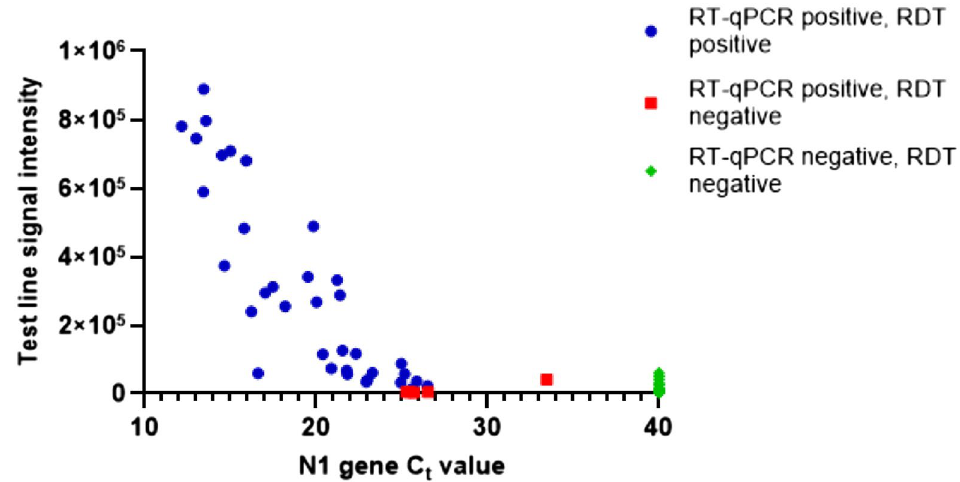
Figure 7. Correlation of SARS-CoV-2 RDT signal intensity to RT-qPCR N1 Ct in patient nasal swabs. SARS- CoV-2 RT-qPCR positive samples that were positive by RDT are shown in blue circles, the majority being ≤ 25 Ct with the highest at 26.5 Ct. RT-qPCR positive samples that were negative by RDT are shown in red squares and are above 25 Ct. SARS-CoV-2 RT-qPCR negative samples are shown in green diamonds, all have low signal intensity levels at the test line location and therefore are